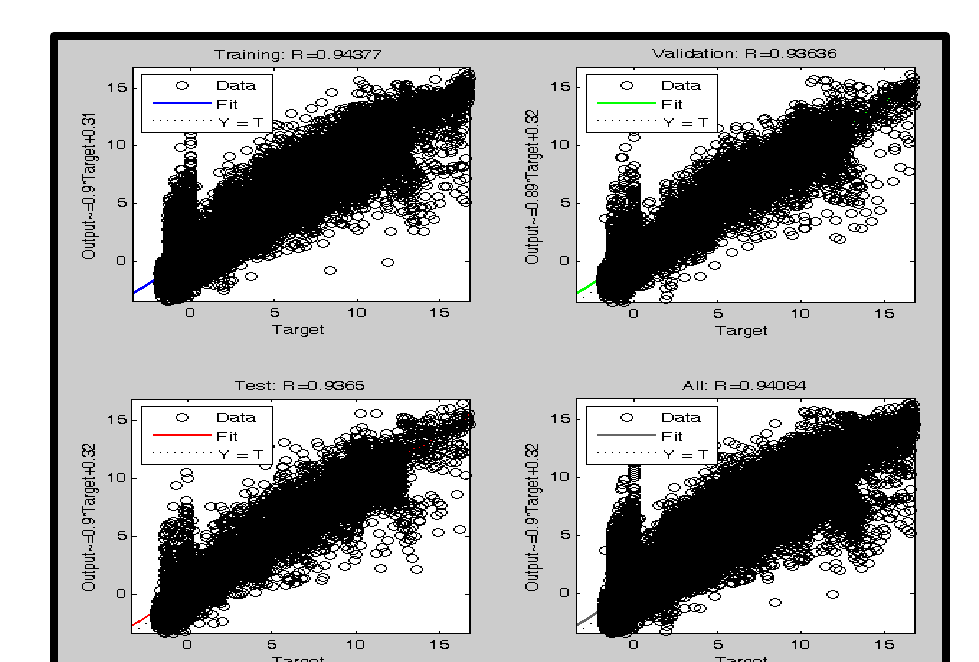
Fig. 5: Implementation of FFBP model based on third